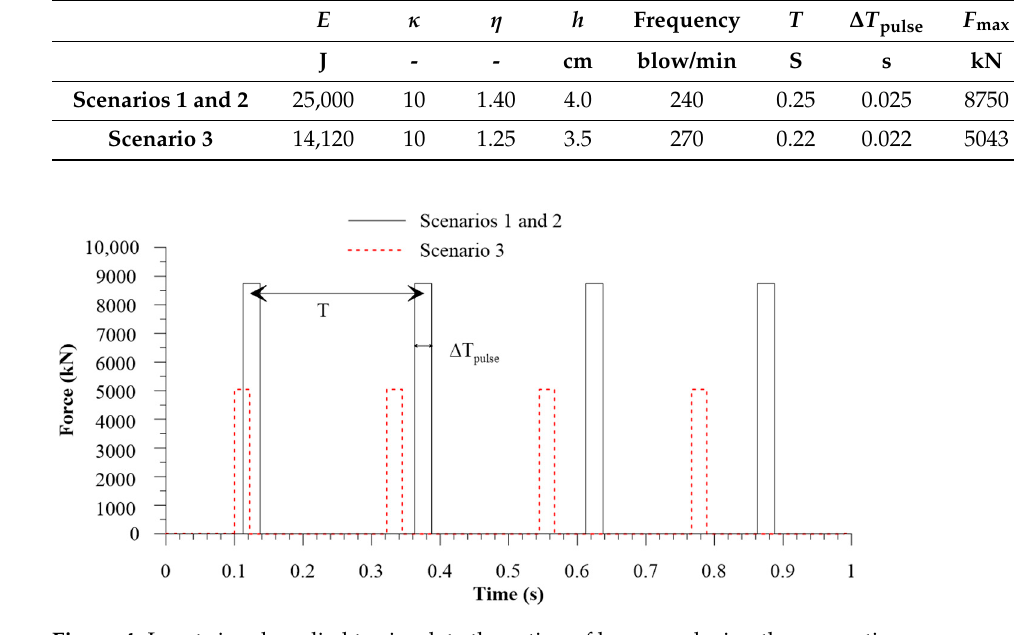
Figure 4. Input signal applied to simulate the action of hammer during the excavation.